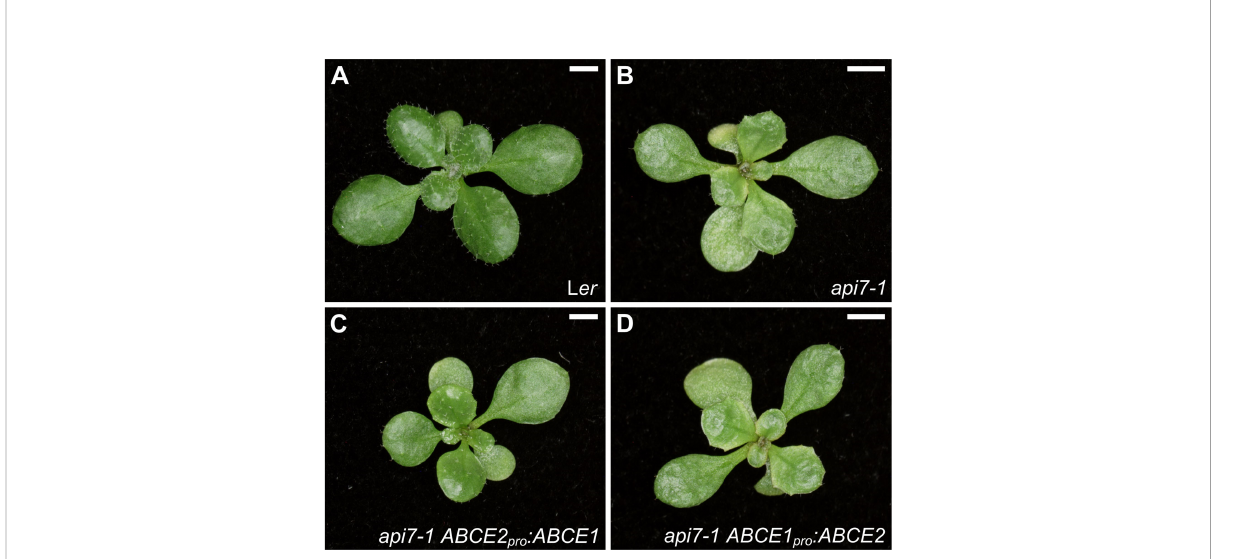
FIGURE 3 Effects of the ABCE2 pro :ABCE1 and ABCE1 pro :ABCE2 transgenes on the morphological phenotype of the api7-1 mutant. Rosettes from (A) L er , (B) api7-1 , (C) api7-1 ABCE2 pro :ABCE1 , and (D) api7-1 ABCE1 pro :ABCE2 plants. Pictures were taken 14 das. Scale bars indicate 2